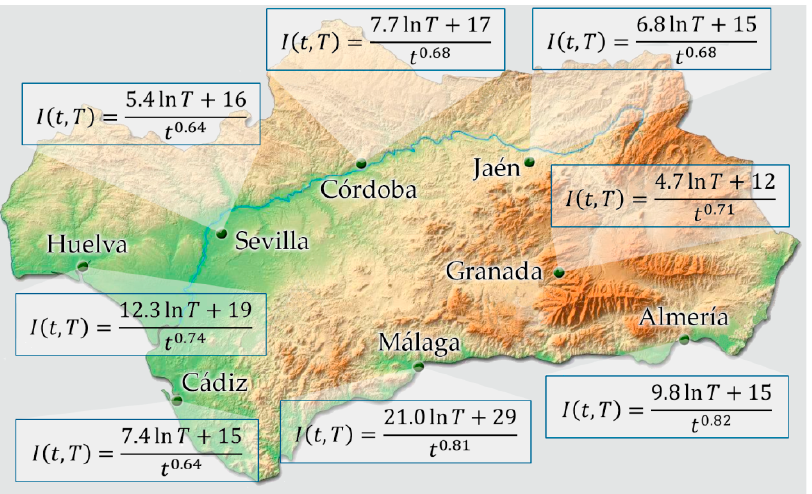
Figure 10. Generalized intensity-duration-frequency equations for the provincial capitals of Anda- lusia, where intensities 𝐼 are in mm, duration 𝑡 in hours and the return period 𝑇 is in years.